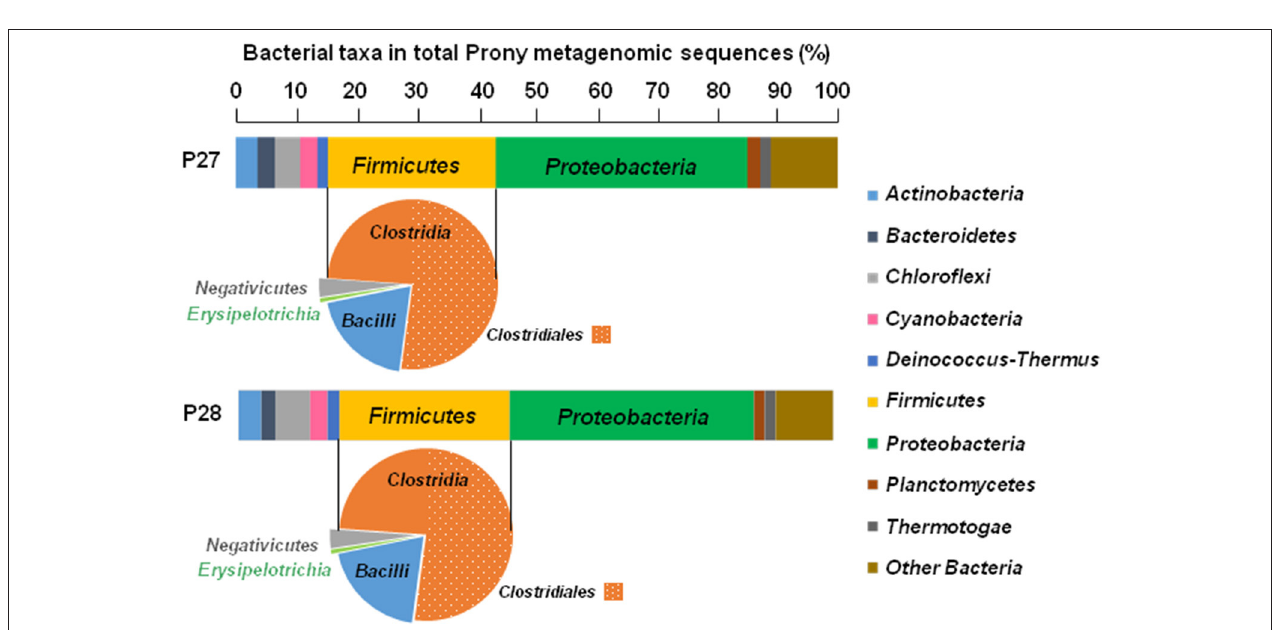
FIGURE 2 | Distribution and taxonomic assignments of putative hydA gene sequences encoding the catalytic subunit of [Fe-Fe] hydrogenases in Prony Hydrothermal Field metagenomes. The histogram shows the relative abundance of major hydA phyla in the total hydA metagenomic sequences ( n = 1678) and pie charts show distributions of “ Firmicutes HydA” classes in the metagenomes P27 and P28 obtained from ST09 site.